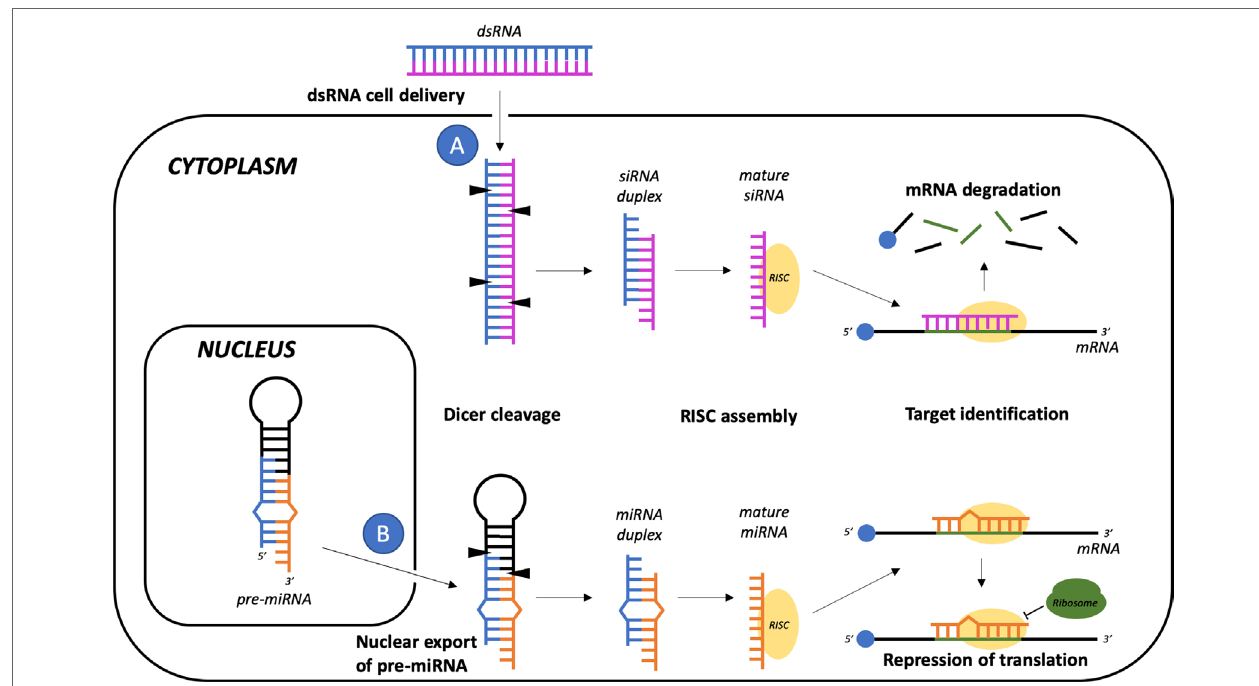
FIGURE 5 | RNA interference-gene silencing pathways mediated by siRNA or miRNA. Even though siRNAs precursors are commonly delivered into the target cells as exogenous double-stranded RNAs (A) while the pre-miRNA hairpin structure is exported from the nucleus after nuclear transcription and processing (B) , in the cytoplasm these small RNA sequences both share common pathways of maturation and target mRNA recognition, which respectively involve DICER cleavage and association of one strand of the duplex with the RNA-induced silencing complex (RISC). Both the siRNA-RISC and the miRNA-RISC complexes may then sequence-specifically hybridize the target mRNA, leading to mRNA degradation or to translation